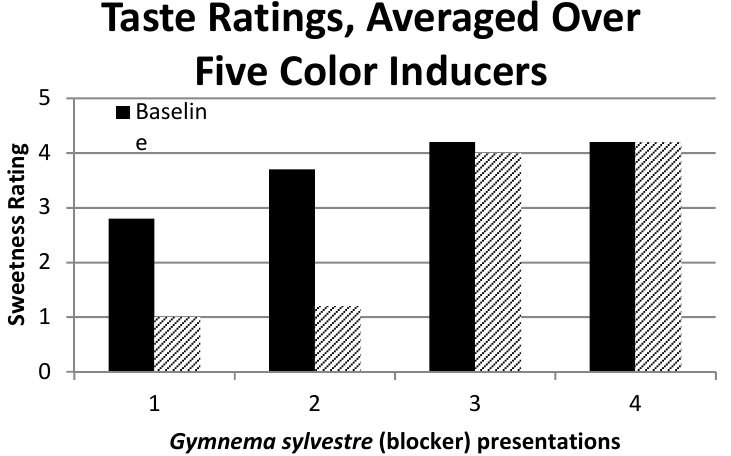
Figure 2. E. C.’s synesthetic sweetness ratings for the baseline and sweetness blocker conditions across four experimental sessions over a 16-month period. The blocker stopped influencing the synesthetic sweetness after the first two presentations.